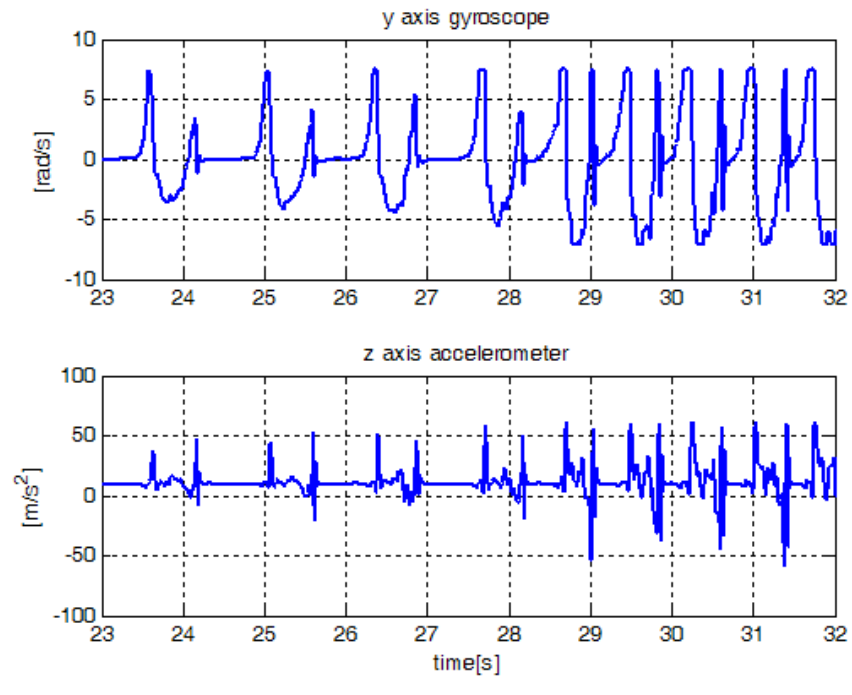
Figure 13. Zero velocity detection comparison when a person is walking and slowly running (Z. V. I. means zero velocity